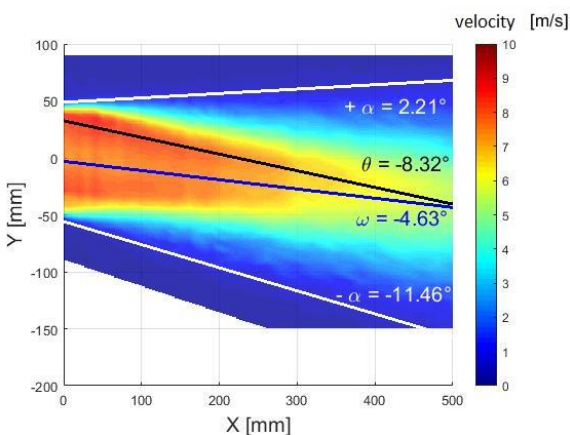
Fig. 7. The d irection angles, CTA – horizontal plane [10]